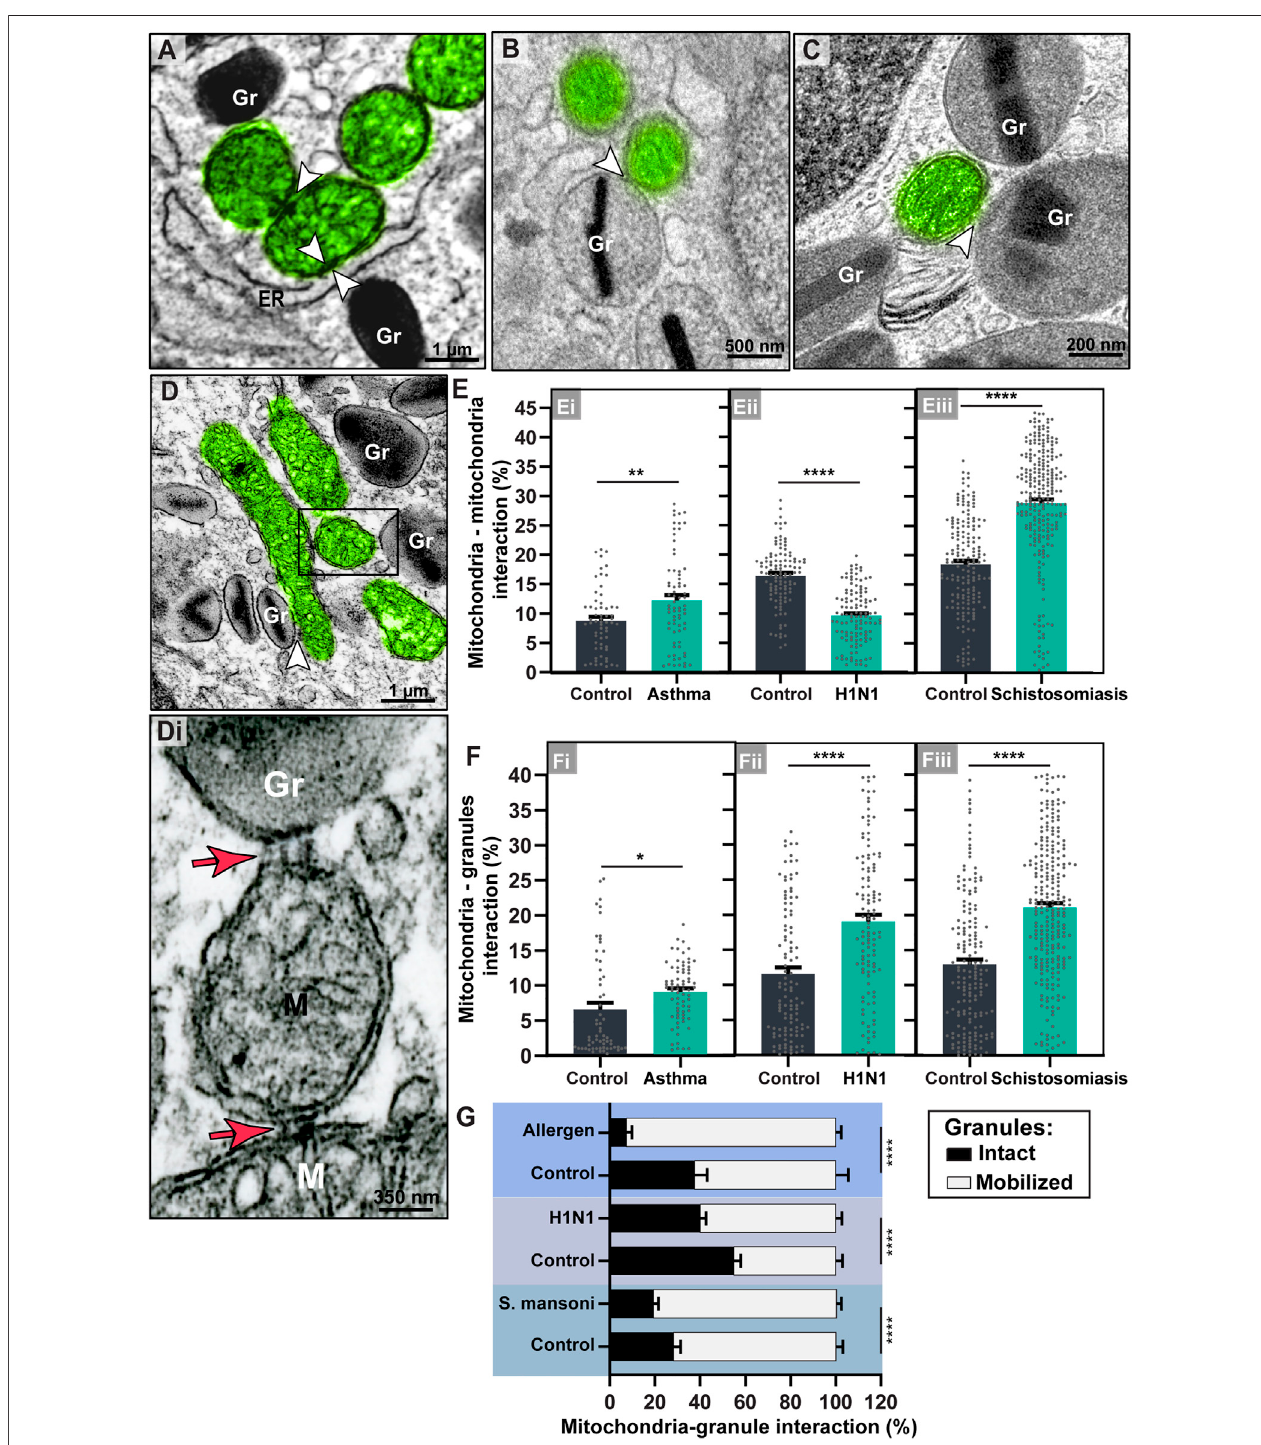
FIGURE 9 | Mitochondrial inter-organelle contact sites within tissue mouse eosinophils. (A – D) Representative electron micrographs showing mitochondrial interactions (arrowheads and boxed area) with the ER, other mitochondria, or secretory granules (Gr) within in fl ammatory eosinophils recruited by schistosomiasis mansoni(A and B, largeintestine), asthma (C, lung), and H1N1 IAV infection (D, BAL). The boxed area in (D) is shown in (Di). Note the presence oftethers (red arrows) at the interface mitochondrion-mitochondrion (M) and mitochondrion-secretory granule (Gr). (Ei-Eiii) Mitochondria-mitochondria contact sites increased within eosinophils in asthma and schistosomiasis but not in response to H1N1 IAV infection. (Fi-Fiii) All in fl ammatory diseases led to a signi fi cant increase of mitochondria-